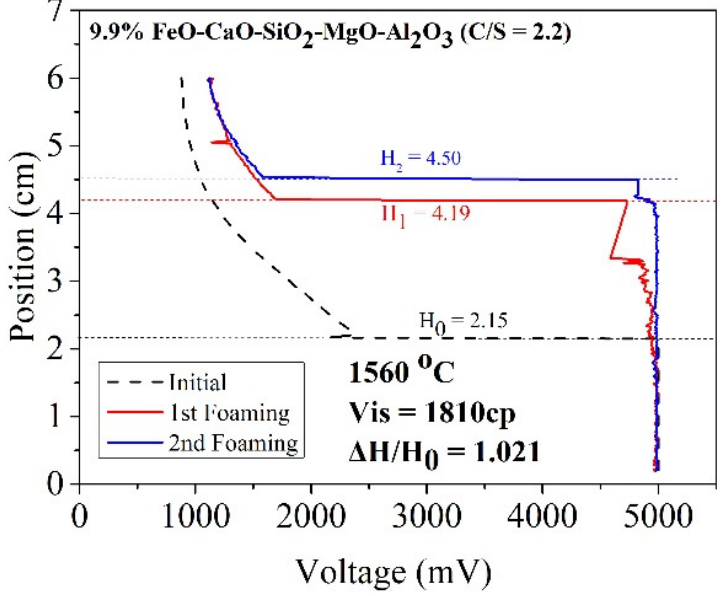
Figure 8. Foaming height of sample A1.